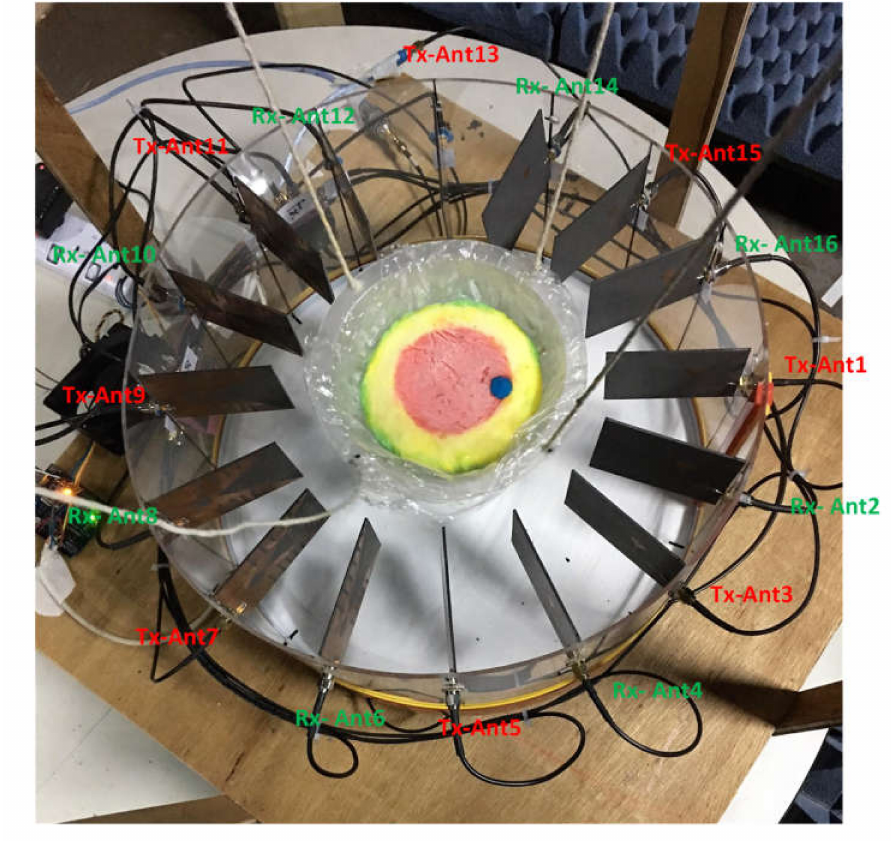
Figure 2. Imaging system setup (data-taking